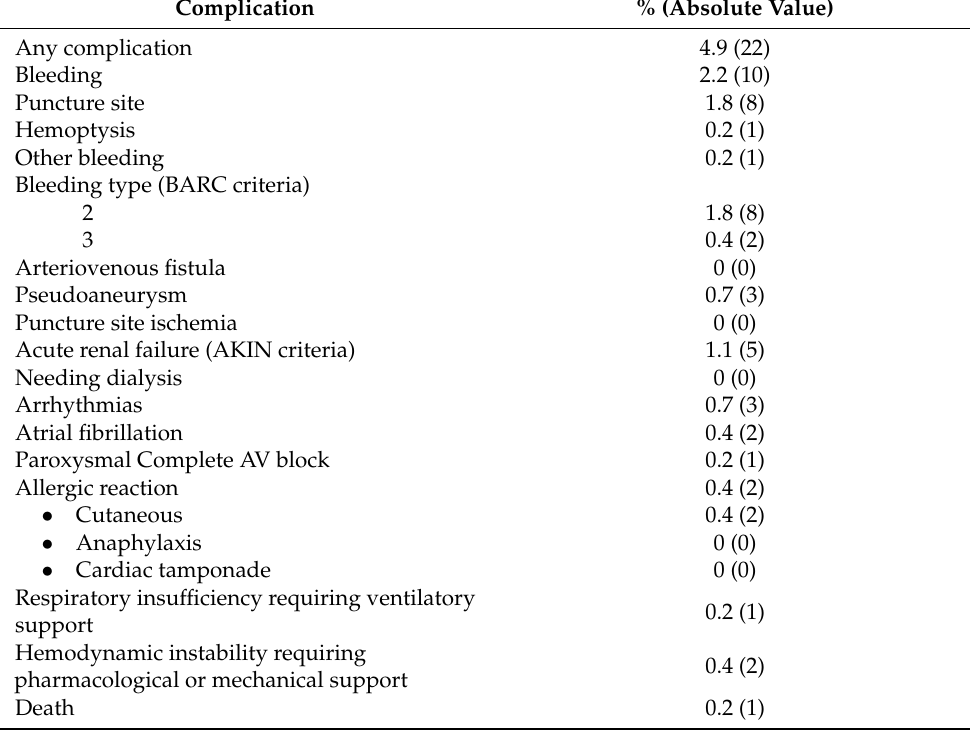
Table 2. Sub-selective pulmonary angiography